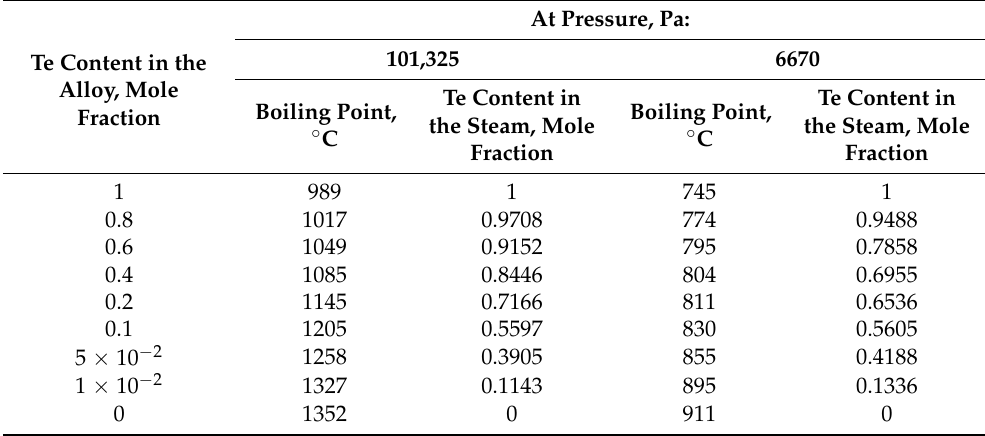
Table 3. Liquid-vapor phase transition boundaries of Al-Al 2 Te 3 system (0 ≤ x Te ≤ 1 ) at atmospheric and low